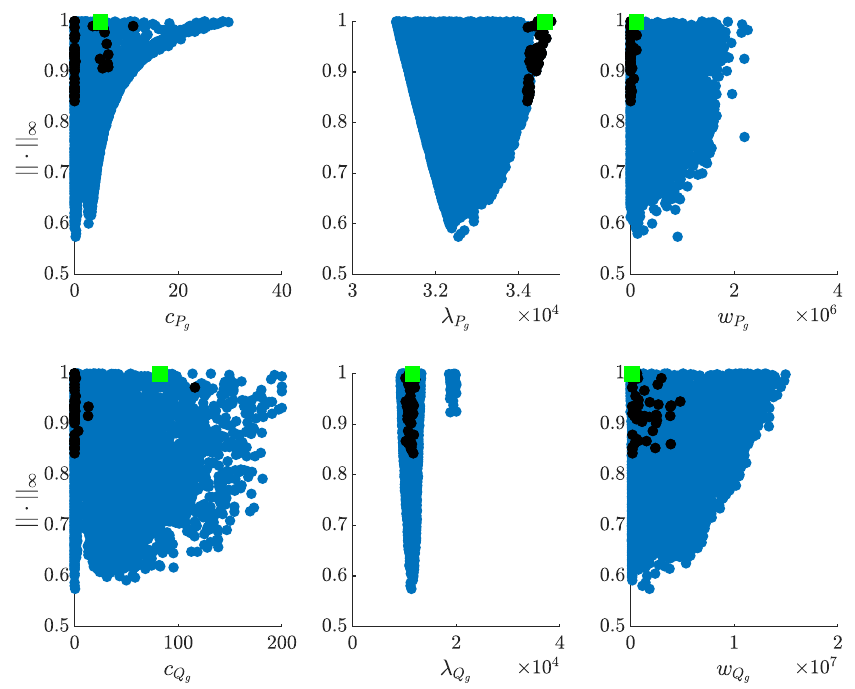
∗ C 1 6 p p ) resulting from application of LD with